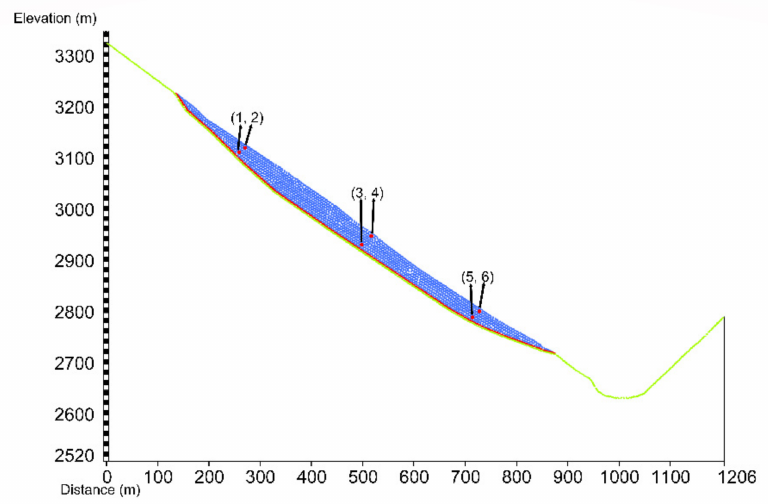
Figure 6. Layout of velocity and displacement monitoring points in the MPM model of the accumula- tion